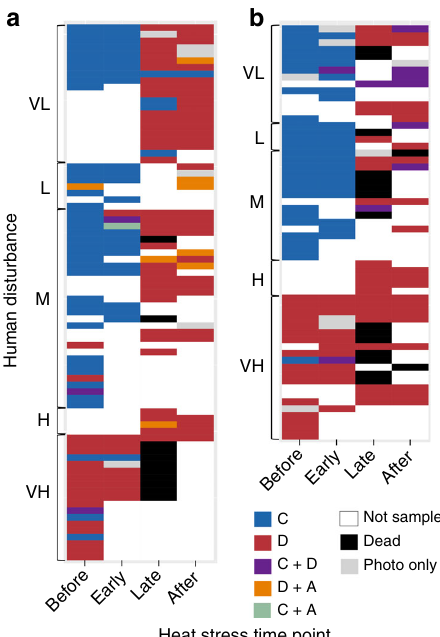
Fig. 5 Time series of dominant symbiont genera in each tagged coral. a Platygyra ryukyuensis ( n = 81). b Favites pentagona ( n = 60). Cell color indicates dominant symbiont genus (former clades: C Cladocopiu m; D Durusdinium , A Symbiodinium ). Co-dominance is shown if the second most- abundant genus was >20% of the total sequence reads. Time points from Fig. 2 are grouped as follows (Before: time points i – iii; Early: time point iv; Late: time point vi; After: time point vii or